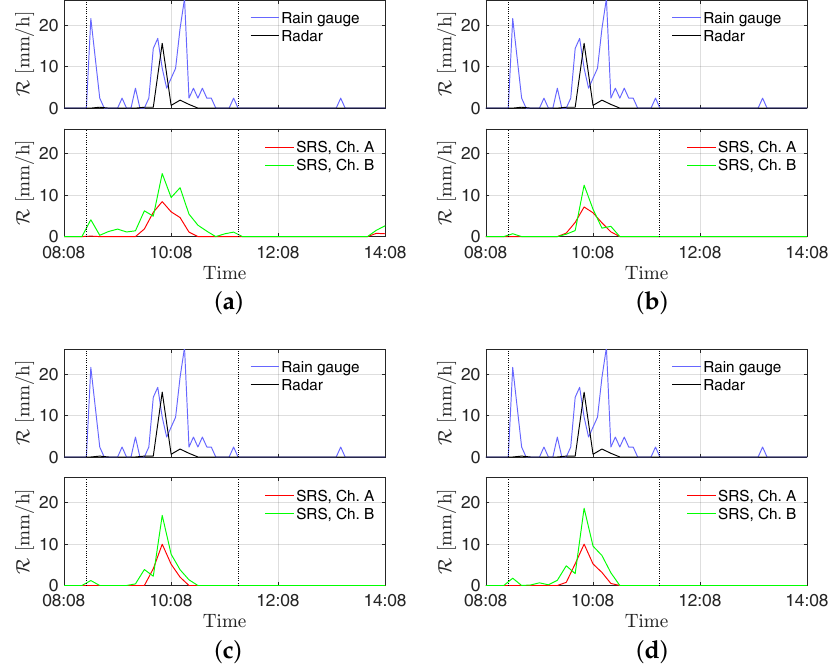
Figure 10. Time series of rainfall intensity R [mm/h] measured at the sites ( a ) S2 − Torcia, ( b ) PZS1, ( c ) Pala Eolica, and ( d ) Uffici Ingr on 14 August 2018. The vertical dotted lines delimit the time window W